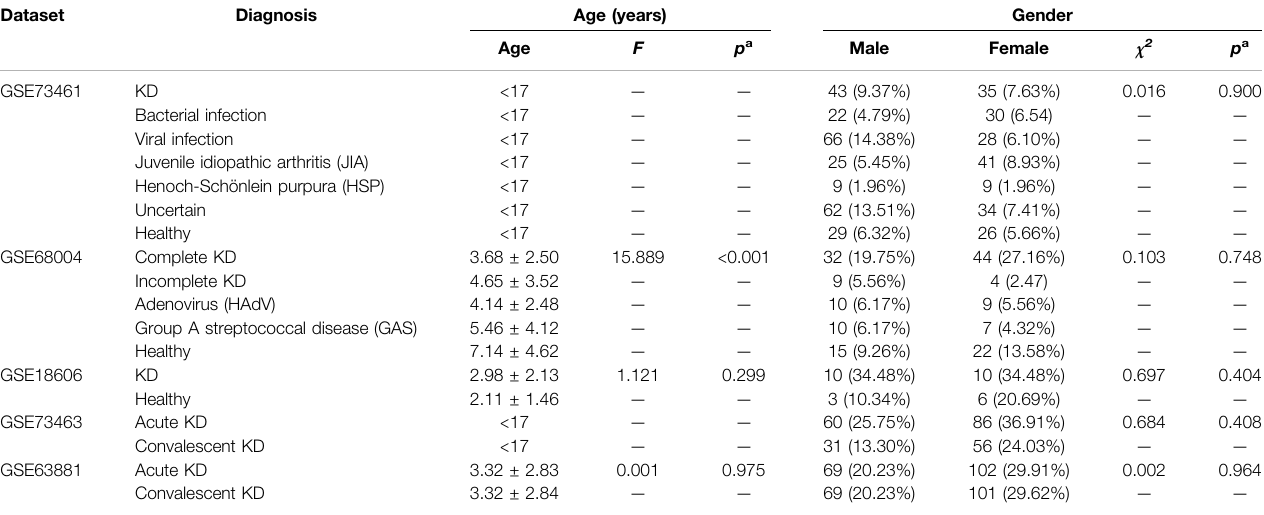
TABLE 1 | Demographic features of each dataset. Dataset